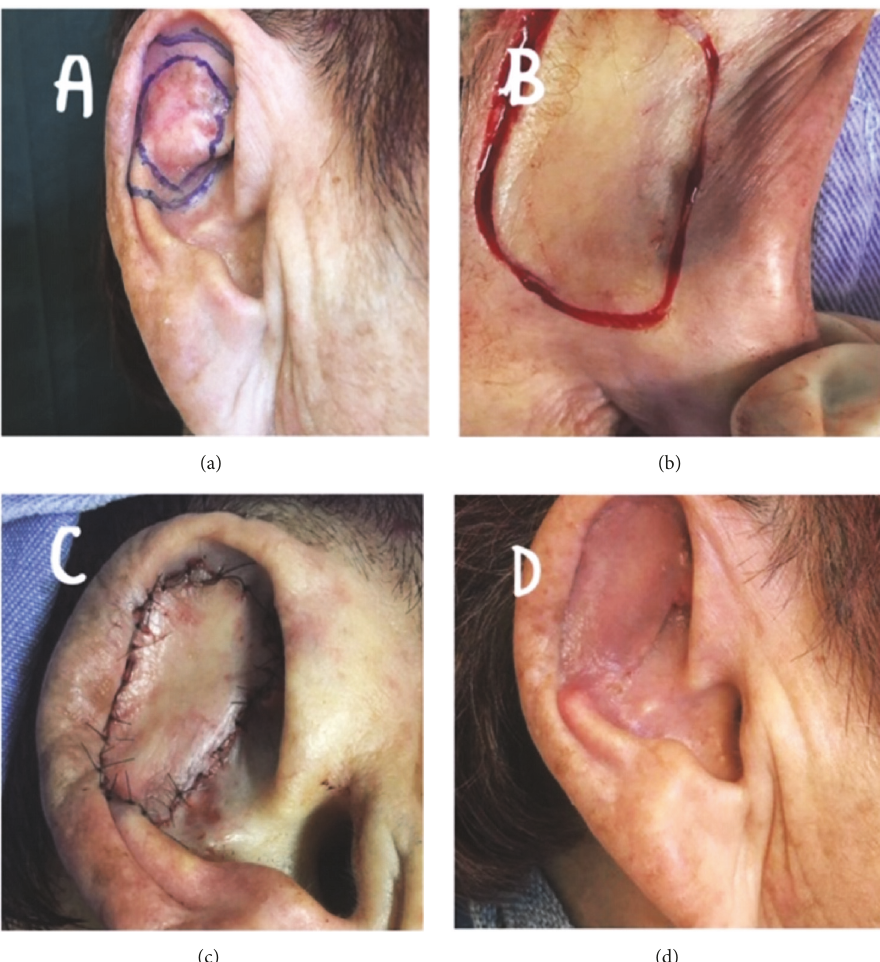
Figure 3: Patient with basal cell carcinoma of the left ear. (a) Boundaries and margins. (b) Retroauricular retail. (c) Immediate result. (d) Final appearance after 30